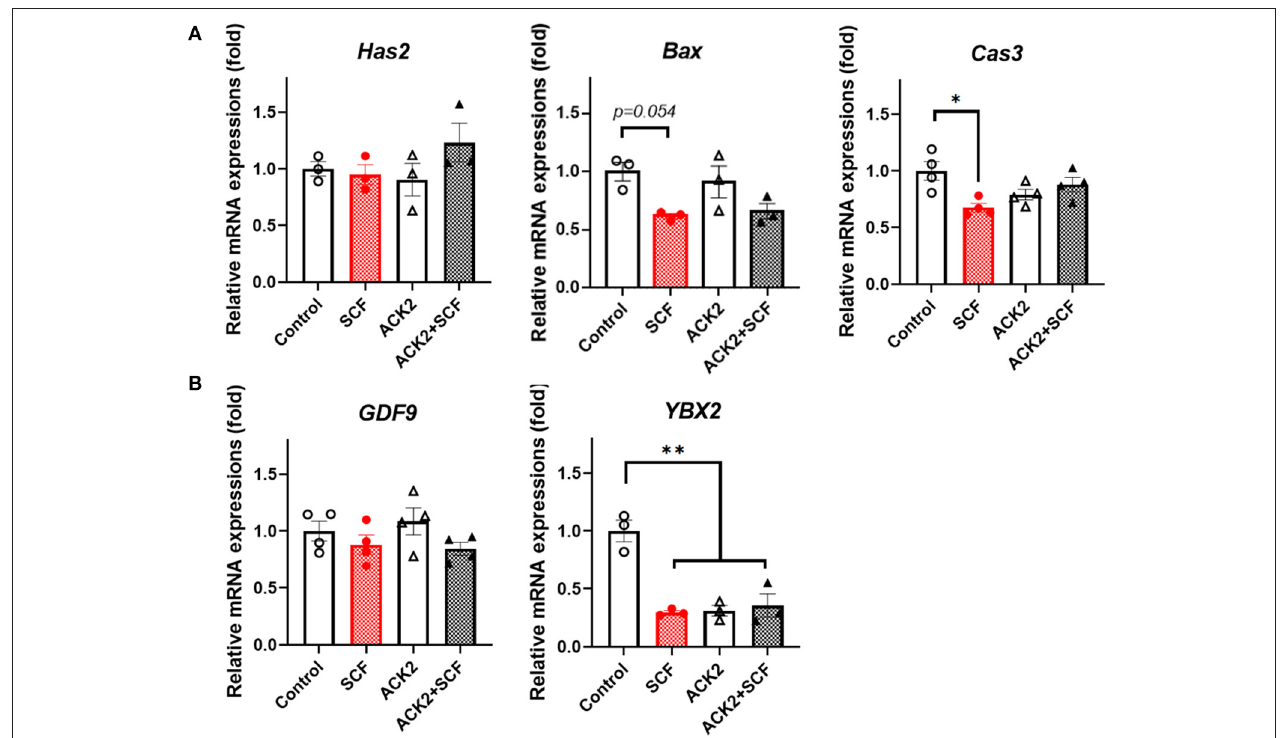
FIGURE 7 | Relative mRNA expression levels in SCF-treated porcine cumulus cells. (A) The mRNA levels of cumulus expansion-related Has2 and apoptosis-related genes ( Bax and Cas3 ). (B) The mRNA levels of oocyte secreted factors ( GDF9 and YBX2 ). For all graphs, the value represents the mean ± SEM. Asterisks indicate statistical significance (* p < 0.05 and ** p < 0.01). Statistical significance was determined by one-way ANOVA. The experiments were replicated three or four